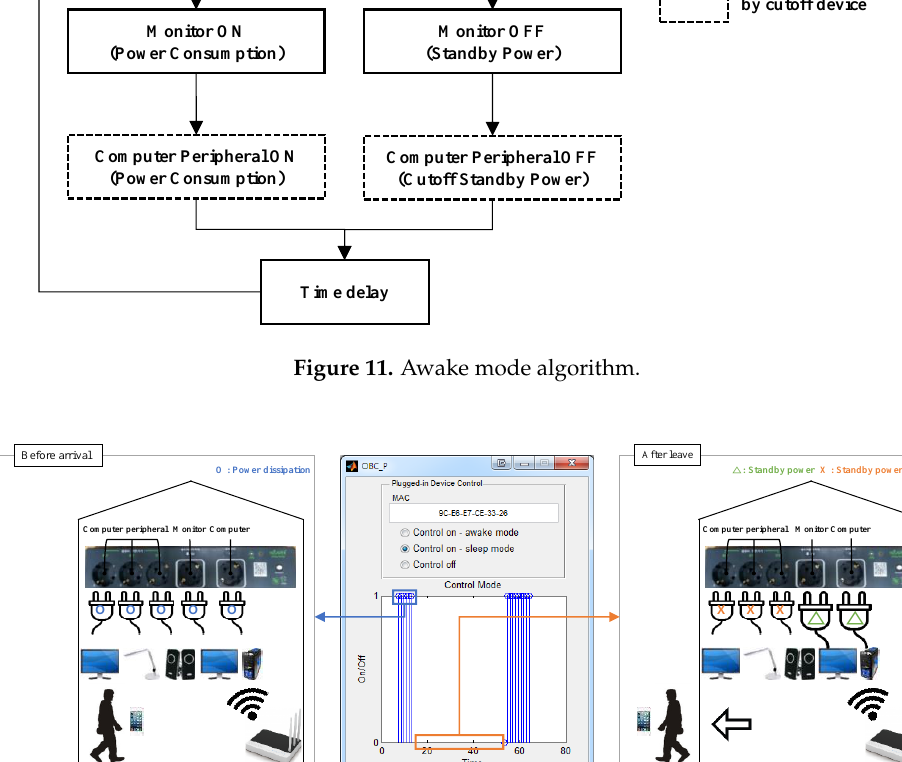
Figure 12. Sleep mode.